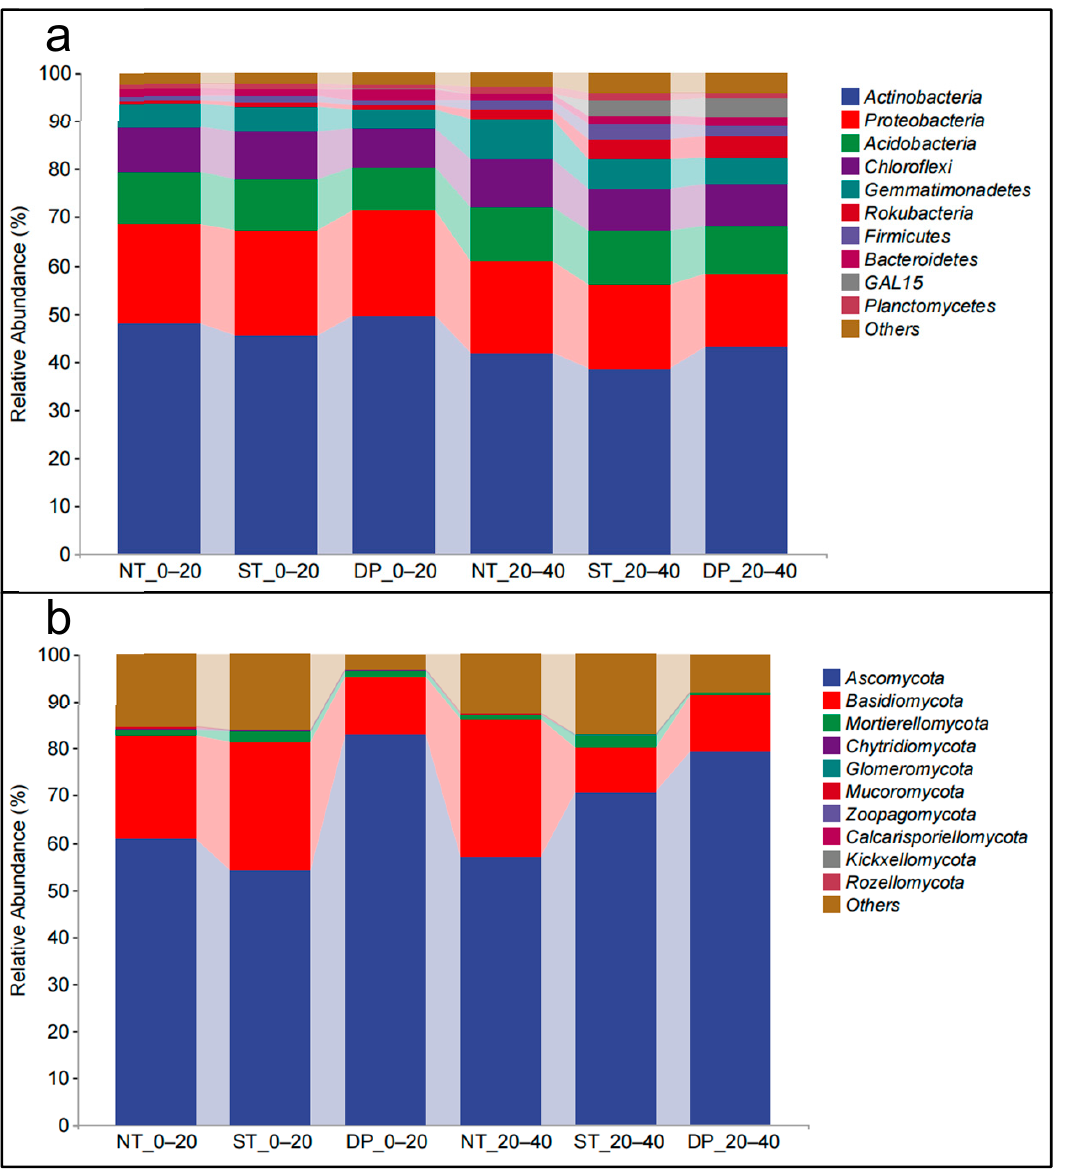
Figure 2. Effect of fallow tillage on relative abundance of phylum taxonomic levels of bacteria ( a ) and fungi ( b ) in the 0–40 cm soil layer. NT: no-tillage; ST: subsoiling tillage; DP: deep plowing. Ascomycota (67.60% ± 13.13%), Basidiomycota (18.60% ± 8.47%), and Mortierellomycota (1.48% ± 0.98%) accounted for 87.65% ( ± 5.04%) of the dominant phyla of the soil fungal community in the 0–40 cm soil layer (Figure 2b). The relative abundances of the remaining species were all less than 1%. In the 0–20 cm soil layer, NT and ST treatments significantly increased the relative abundance of Basidiomycota compared with the DP treatment. In